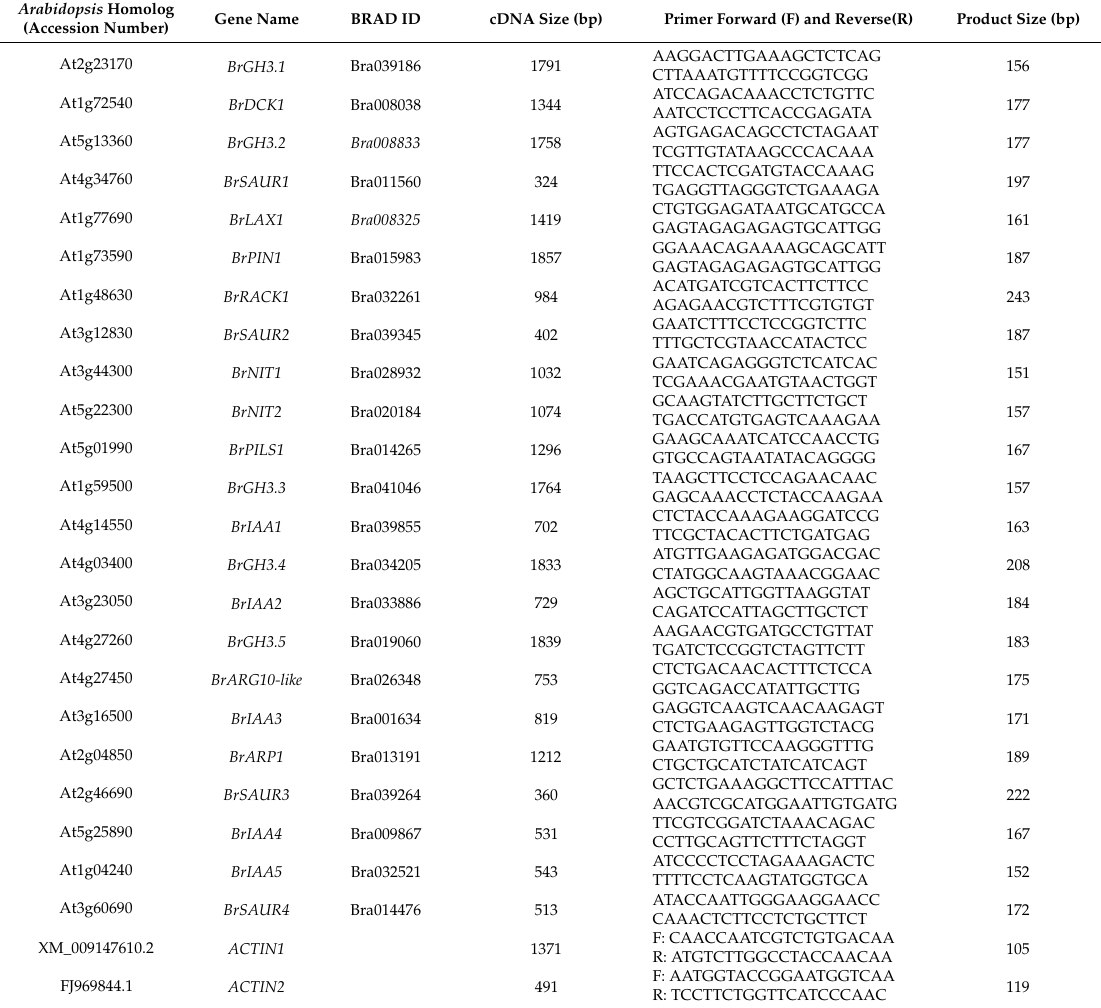
Table 4. List of primer sequences used for qRT-PCR of auxin-related